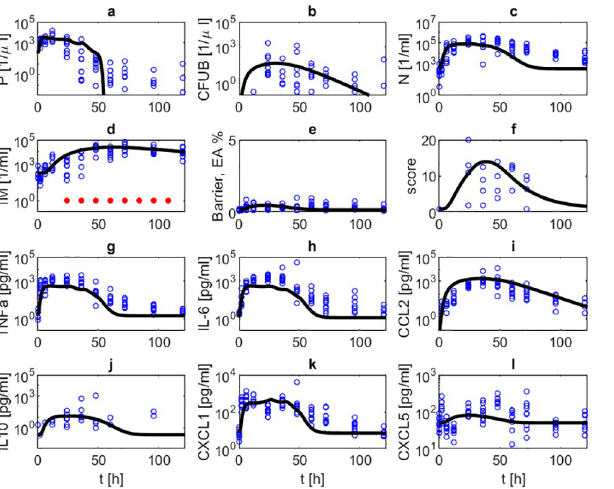
Fig 5. Infection with 5 � 10 6 Streptococcus pneumoniae treated with ampicillin (0.4 mg/mouse) every 12h, starting at 24h. We compare results of model simulation with data under antibiotic treatment. Time series of pneumococcal population in BAL (a) and blood (b), neutrophils in BAL (c), inflammatory macrophages in BAL (d), barrier function (e), histologic score (f), TNF- α in BALF (g), IL-6 in BALF (h), CCL2 in BALF (i), IL-10 in BALF (j), CXCL1 in BALF (k) and CXCL5 in BALF (l) are displayed. The solid black curve represents simulation results. Blue circles represent data. Red dots represent the time points of antibiotic treatment. Treatment results in eradication of bacteria from alveolar spaces and blood. Immune cells, cytokine levels and barrier function also normalize except for macrophages staying elevated during observation period.